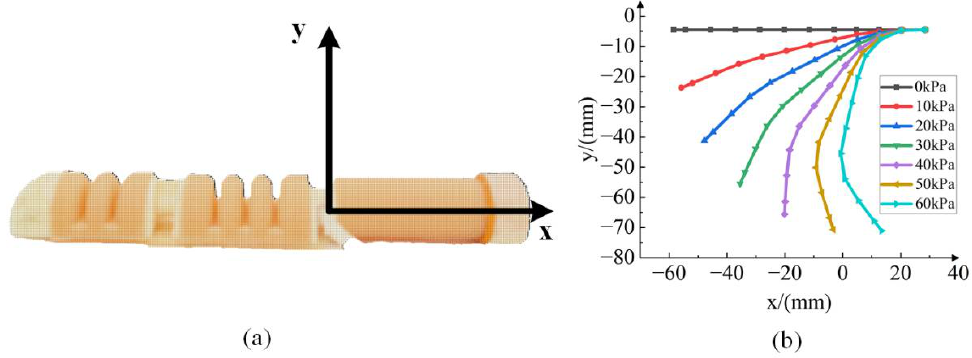
Figure 12. ( a ) x–y plane coordinate system virtual partition; ( b ) finger bending shape under different air pressures.